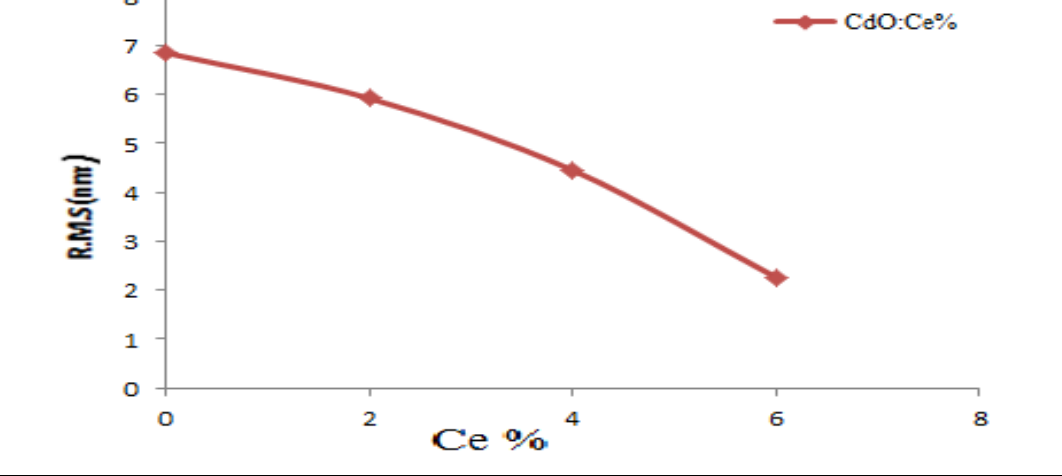
Fig. 9: Variation of Root mean square with Ce concentration for CdO prepared silicon substrates.